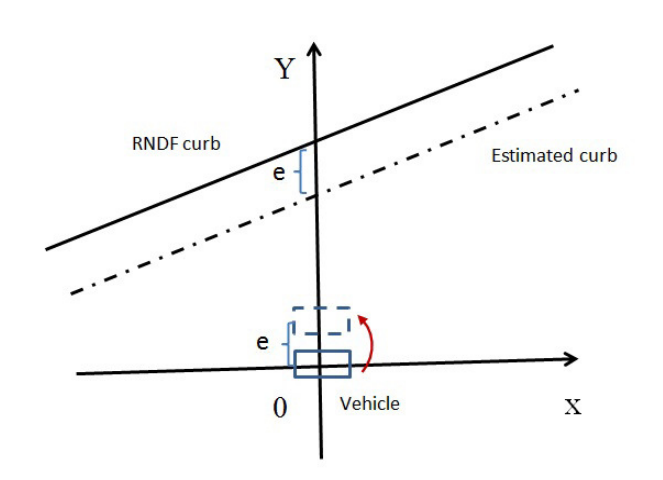
Figure 8. Lateral